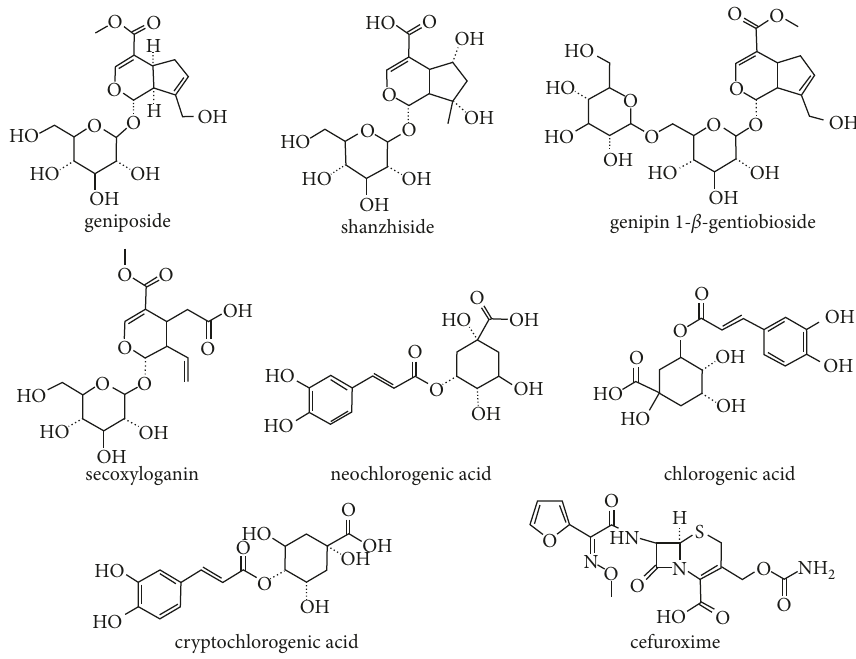
Figure 1: The chemical structures of seven ingredients of RDN and cefuroxime.